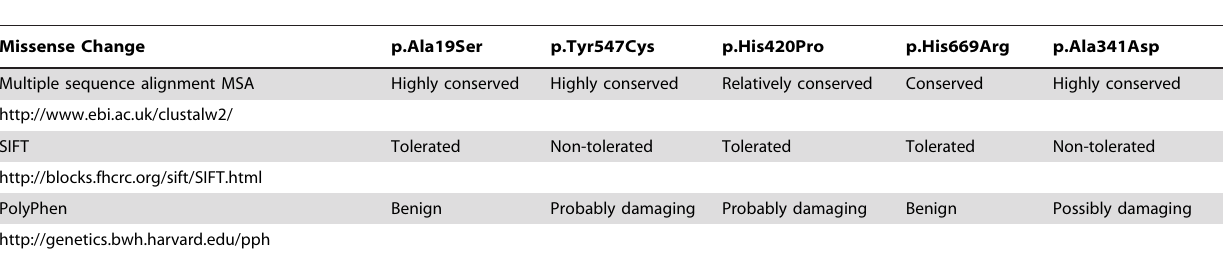
Table 2. Results of computational analysis for missense changes in ABCD1 gene from Argentinean patients.